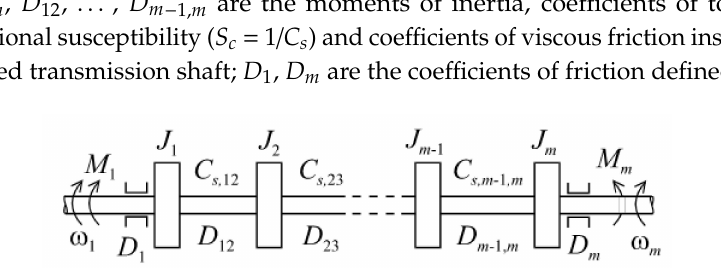
Figure 1. Kinematic structure of transmission shaft transferred into m discrete